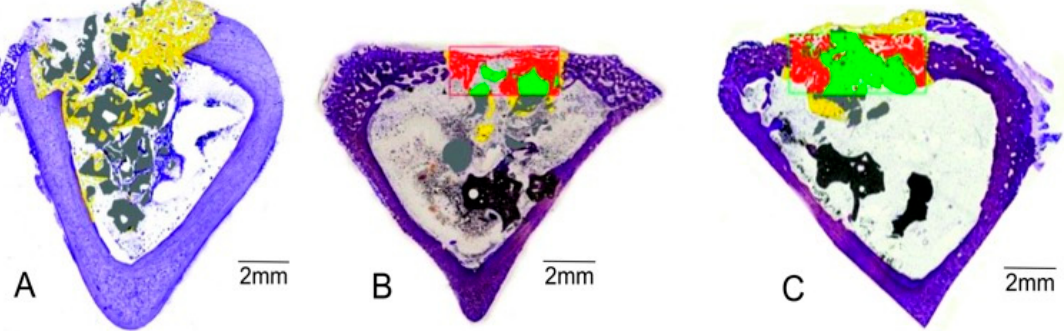
Figure 3. Histomorphometrical analysis of the Si ‐ TCP scaffolds. ( A ) 15; ( B ) 30 and ( C ) 60 days after implantation. Light gray and dark gray areas are residual biomaterial without resorption. The yellow zones correspond to new bone. The regions of interest (ROIs) correspond to the red rectangles. The green color inside the ROI is the biomaterial and the red color is bone. The red color in the middle of the ROI is new bone and the red color in the periphery is old bone. The new bone is thinner than the old one.